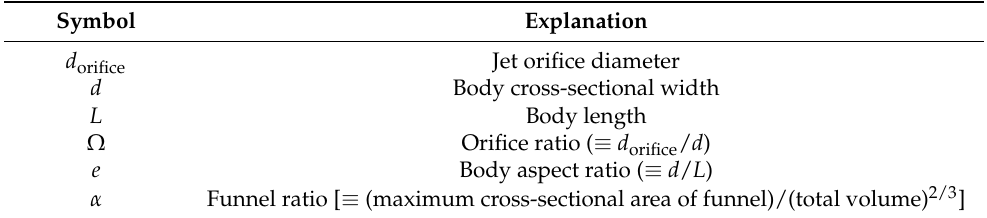
Table 1. List of